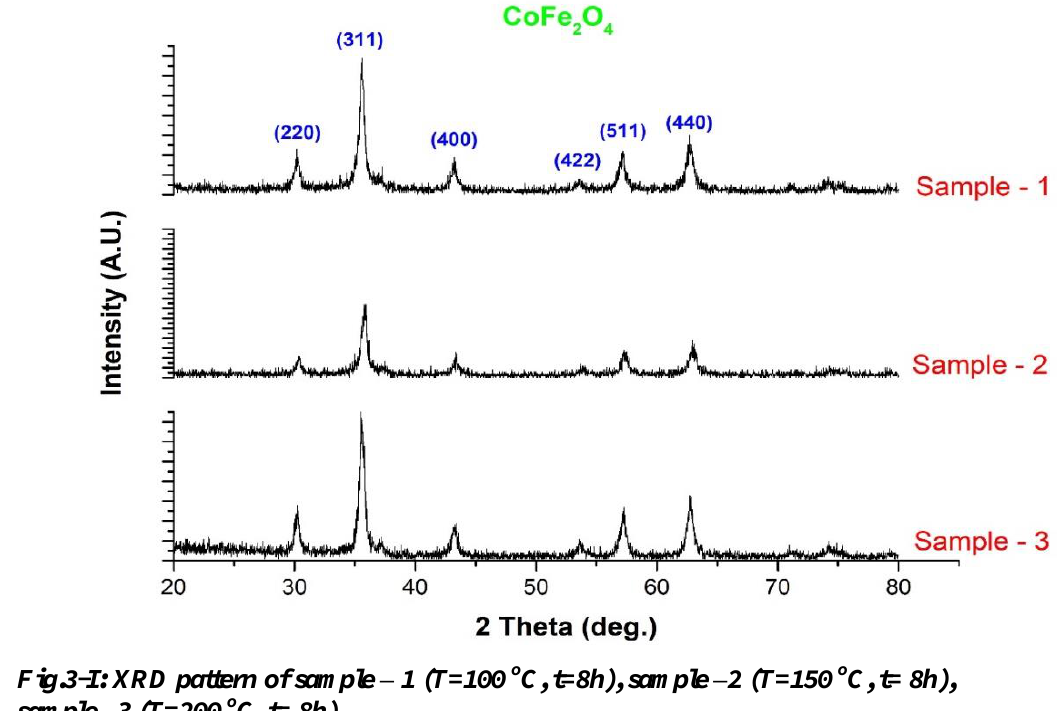
Fig.3-I: XRD pattern of sample – 1 (T=100 o C, t=8h), sample –2 (T=150 o C, t= 8h), sample –3 (T=200 o C, t= 8h).